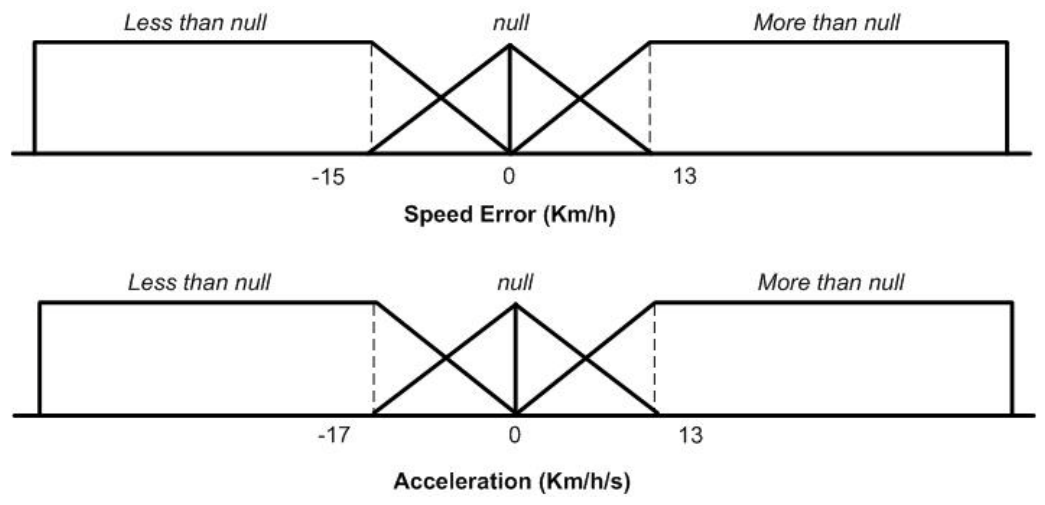
Figure 5. Longitudinal control input membership function: speed error and